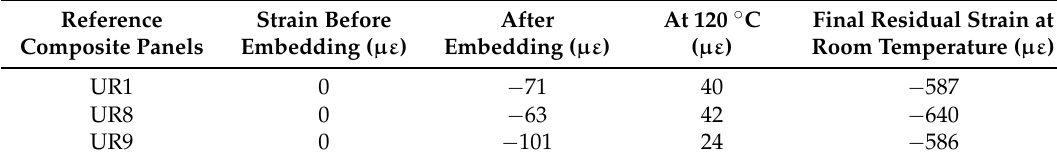
Table 3. A summary of the strain data measured by the embedded EFPI sensors at different stages of processing for three reference composite panels where no pre-stress was